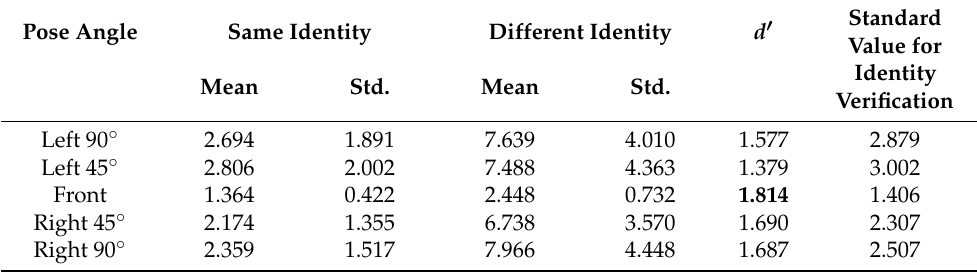
Table 6. Mean and Std. of EDs between reciprocal landmarks in each region.